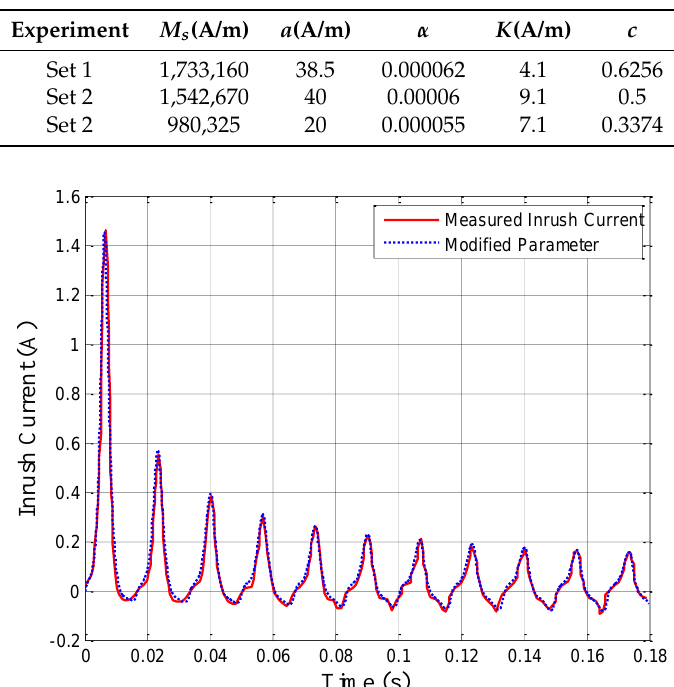
Table 3. J–A parameters generated by the automatic algorithm.